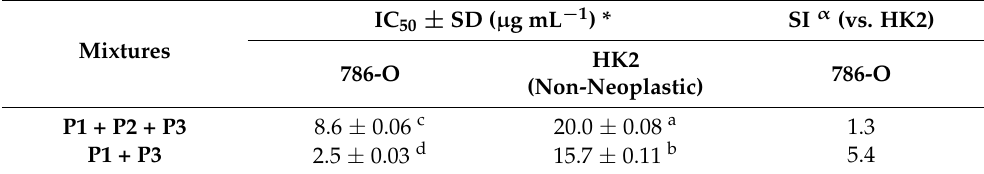
Table 4. The IC 50 values and respective selectivity indexes of the combinations of the subfractions (in equal parts) obtained from the G18.EE-EtOAc fraction (72 h treatment) in RCC cells.